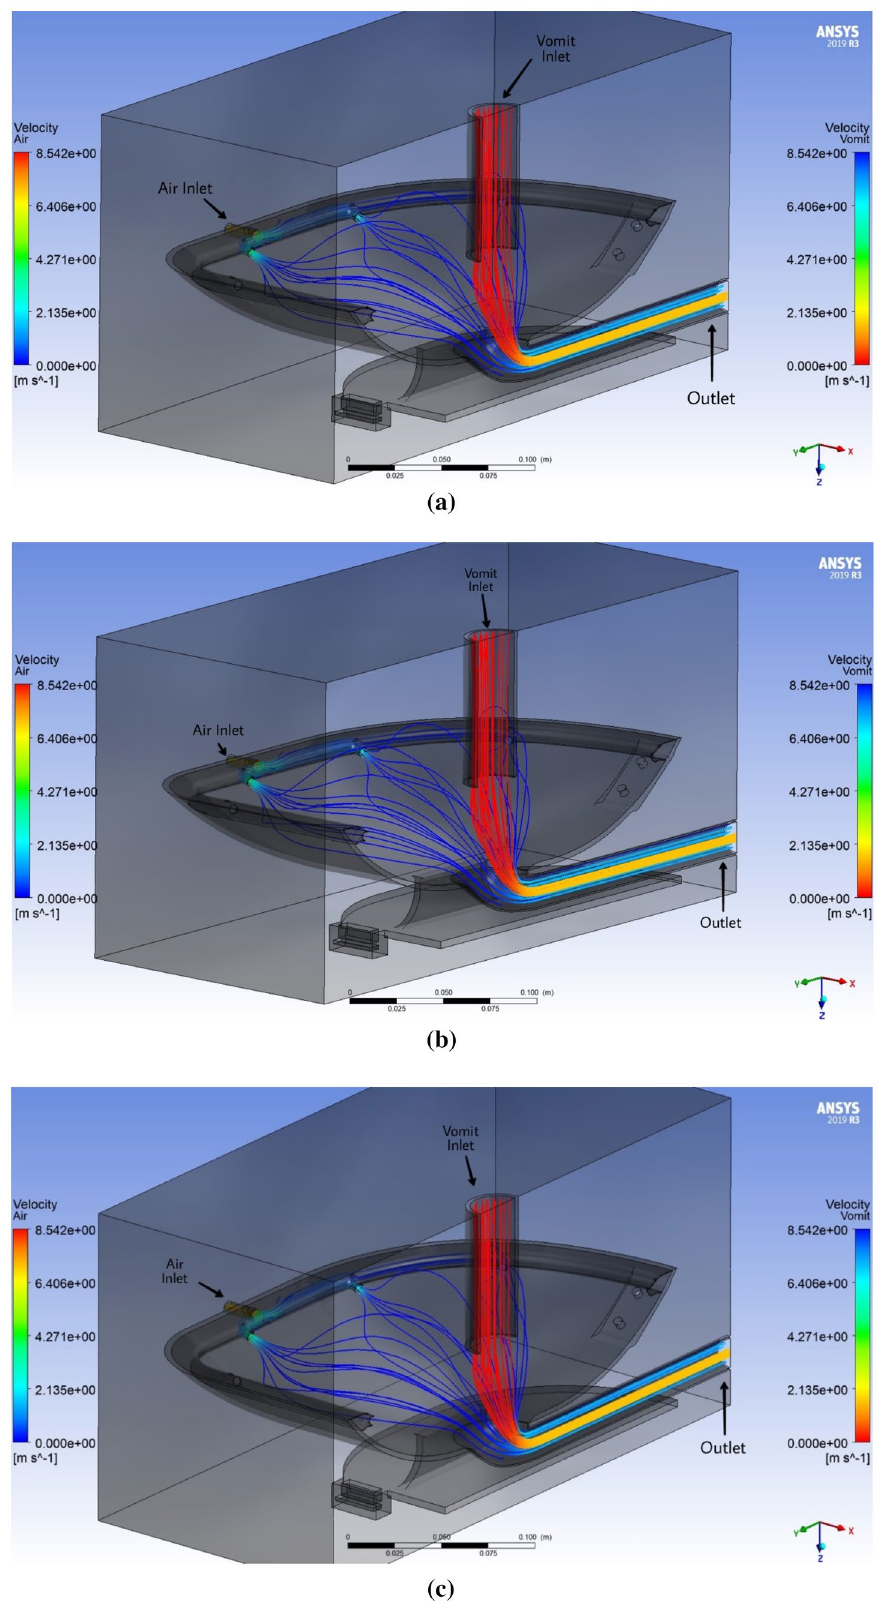
Fig. 19 The air flow simula- tions through nozzles provided to the basin are done for three different conditions such as a for Mars gravity (3.721 m/s 2 ), b for the Moon gravity (1.62 m/ s 2 ), c for the zero- or micro- gravity i.e., the space gravity. The vomit is flushed with air at a high velocity around 8 m/s towards the fecal waste stor- age. The CFD analyses are car- ried out to study flow patterns of (i) air through the nozzles of AFFS, and (ii)